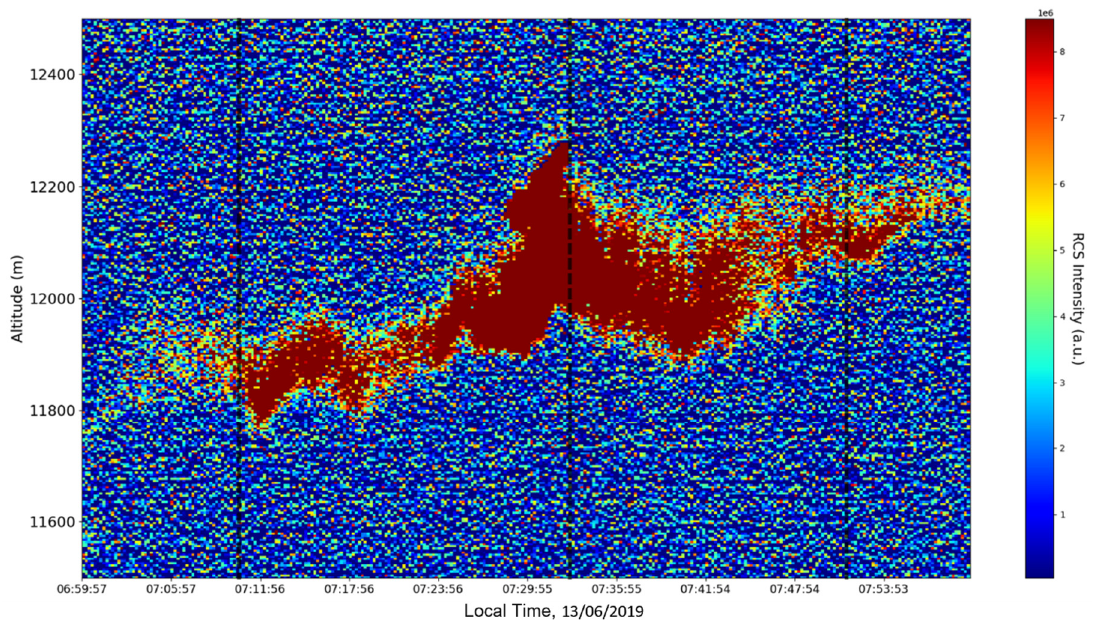
Figure 3. RCS time-series, Bucharest, Romania, 13 June 2019; zoomed-in, superior region of interest.